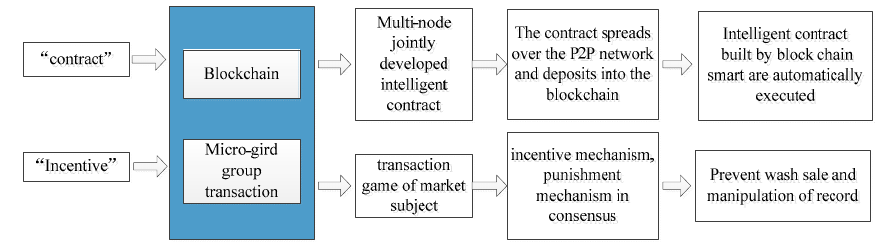
Figure 4. Smart contract coupling.